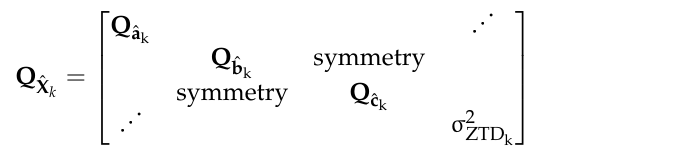
refer to the respective VC matrices for the unknown Q c k ˆ